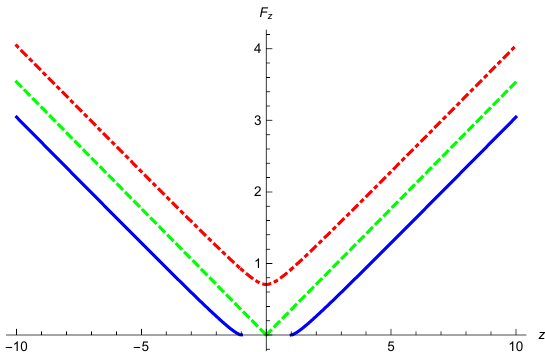
Figure 1 . The z dependence of the free energy, for (cid:12)xed g , N and n 0 , is plotted for (cid:20) = (cid:0) 1 (red and dot-dashed curve), for (cid:20) = 0 (green and dashed curve), and for (cid:20) = 1 (blue and solid curve). Even though F z is plotted as a continuous function of z , only quantized values of z correspond to SCFTs, as given in (4.20) for (cid:12)xed genus g